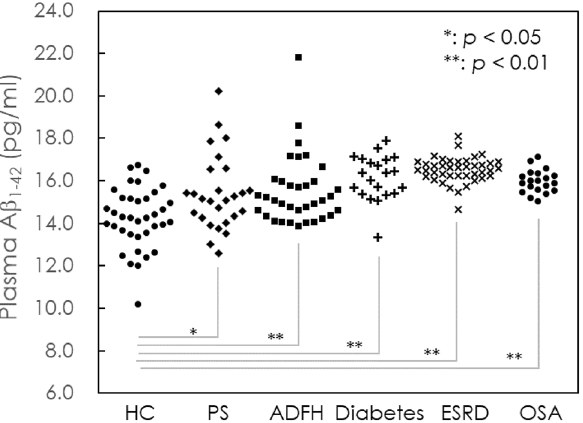
Figure 1. Dot plot of measured levels of Aβ 1–42 in the plasma of healthy control (HC), poststroke subjects (PS), individuals with a family history of Alzheimer’s disease (ADFH), and patients with end-stage renal disease (ESRD), obstructive sleep apnea (OSA) and Alzheimer’s disease (AD). *p < 0.05 and **p < 0.01 versus healthy